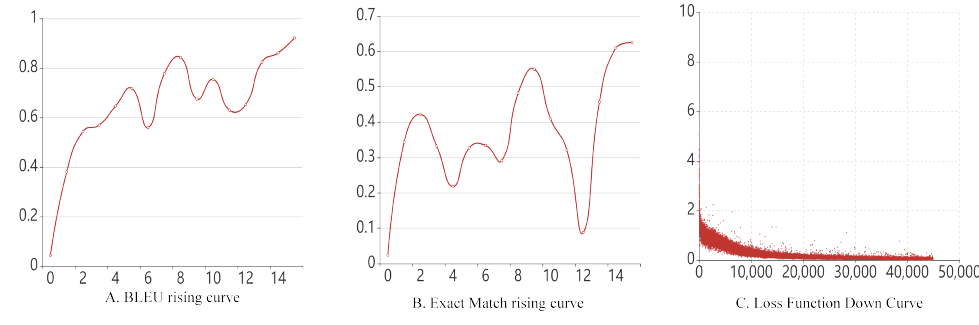
Figure 10. Parameter change